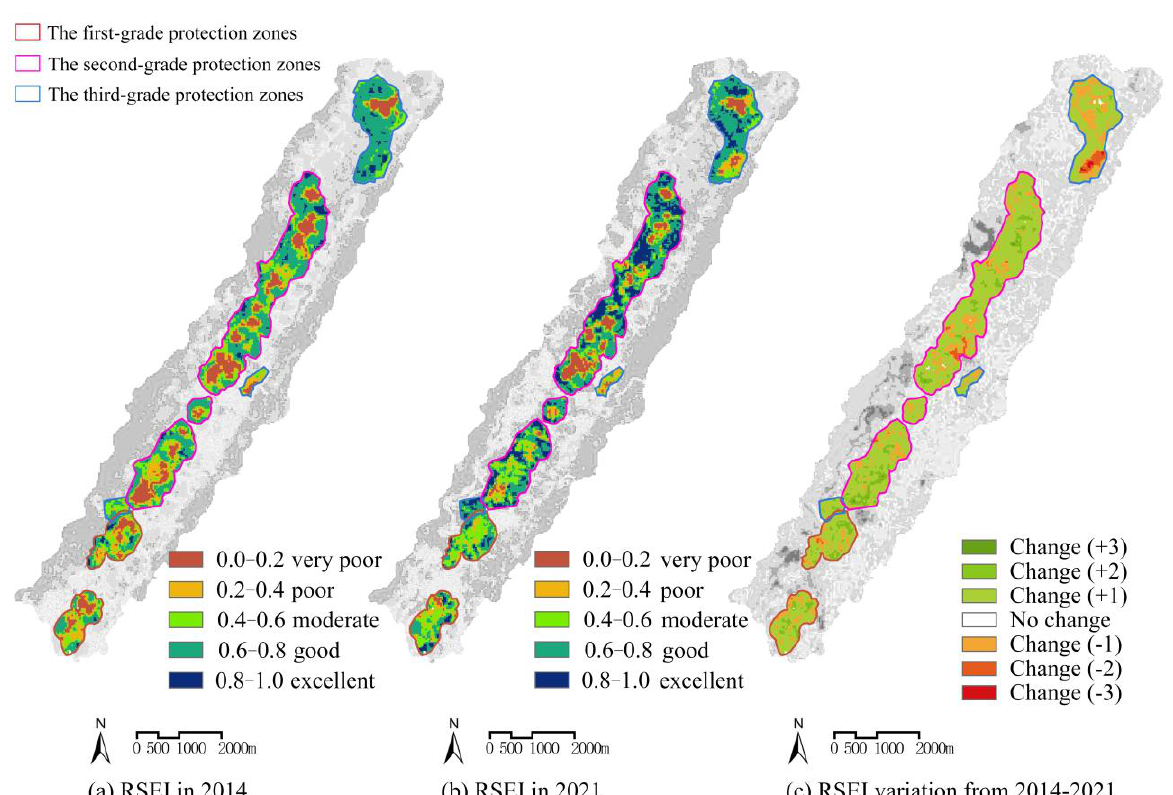
area of each grade and the proportions were determined (Table 2).